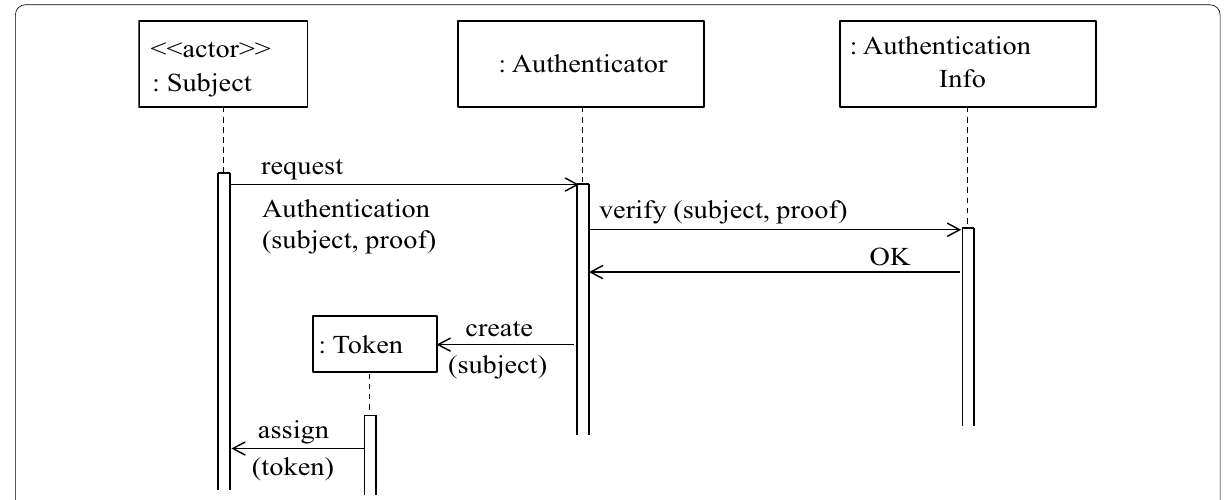
Fig. 2 Sequence diagram for the use case “authenticate a